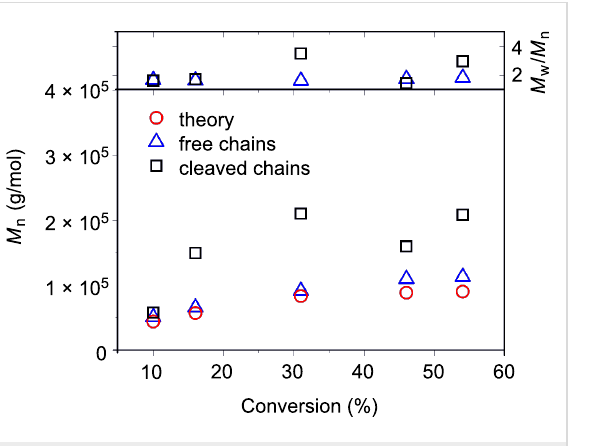
polymerization, and similar kinetics are observed in the experi- ments with and without particles, as expected since SiP–RAFT only accounts for ca. 10% of the total RAFT agent in the reac- tion.